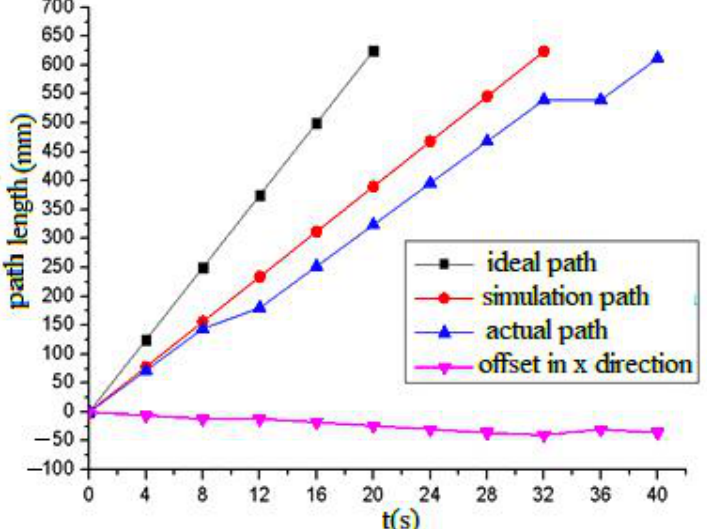
Figure 18. Comparison of the ideal path, the planned path and the actual path.